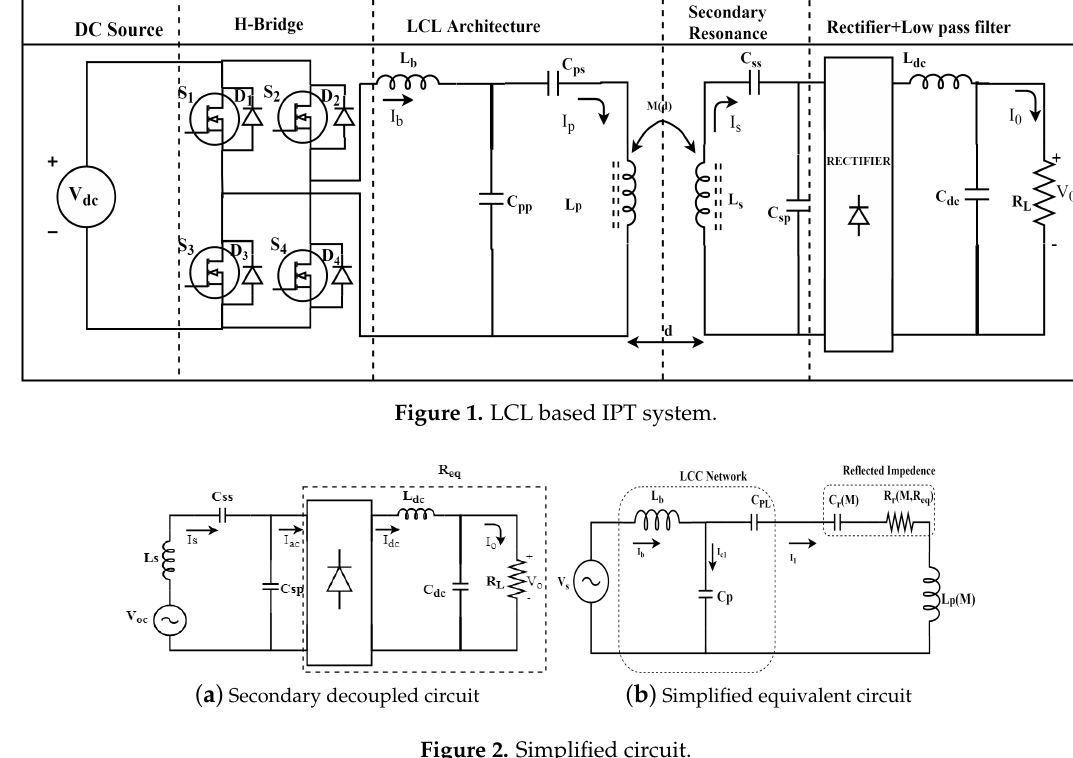
Figure 2. Simplified